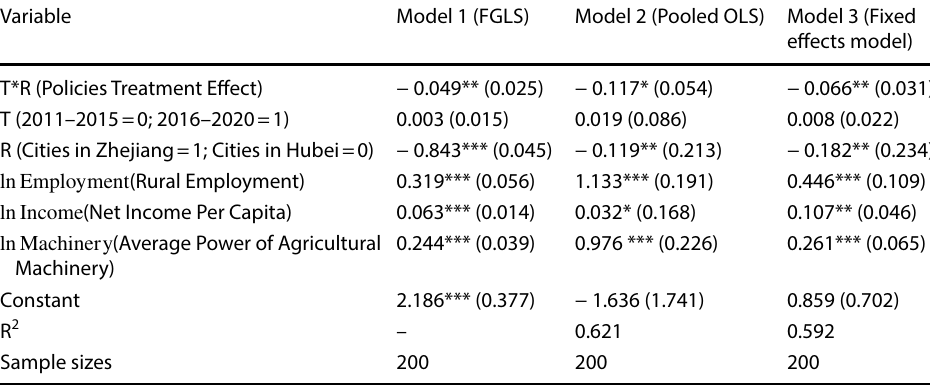
Table 11 Policy treatment effect on agricultural GHG emissions based on DID